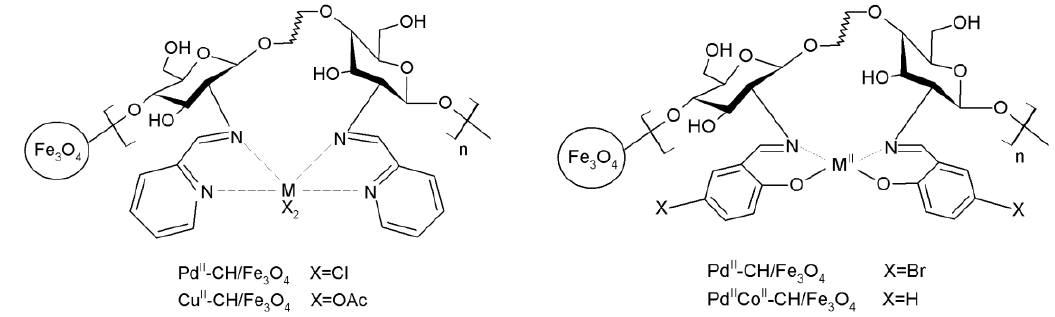
Figure 17. Magnetic chitosan-based metal catalysts with high activity in the Heck coupling reaction.